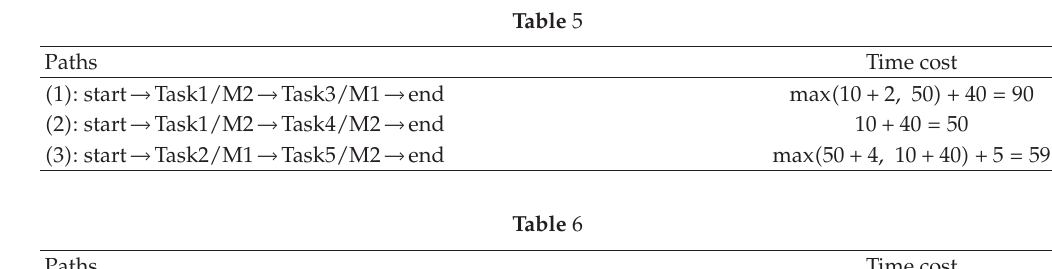
Paths Time cost (cid:3) 1 (cid:4) : start → Task1/M2 → Task3/M1 → end max (cid:3) 10 (cid:8) 2 , 50 (cid:4) (cid:8) 40 (cid:9)